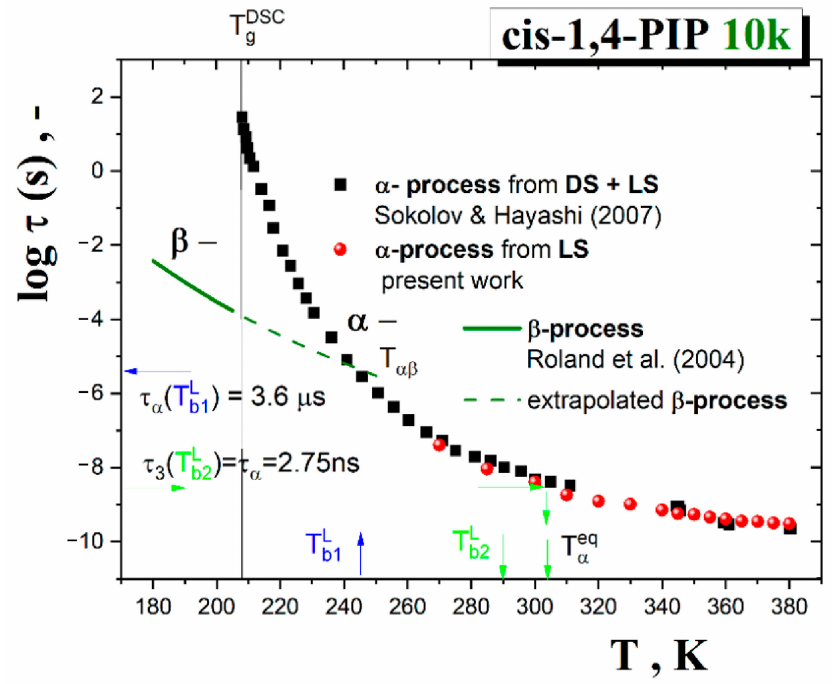
Figure 13. Time scales of o -Ps annihilation, τ 3 , and the primary α process, τ α , from the present LS and published BDS [50] data and the secondary β process, τ β , from DS study on 1,4-PIP500k in Ref.